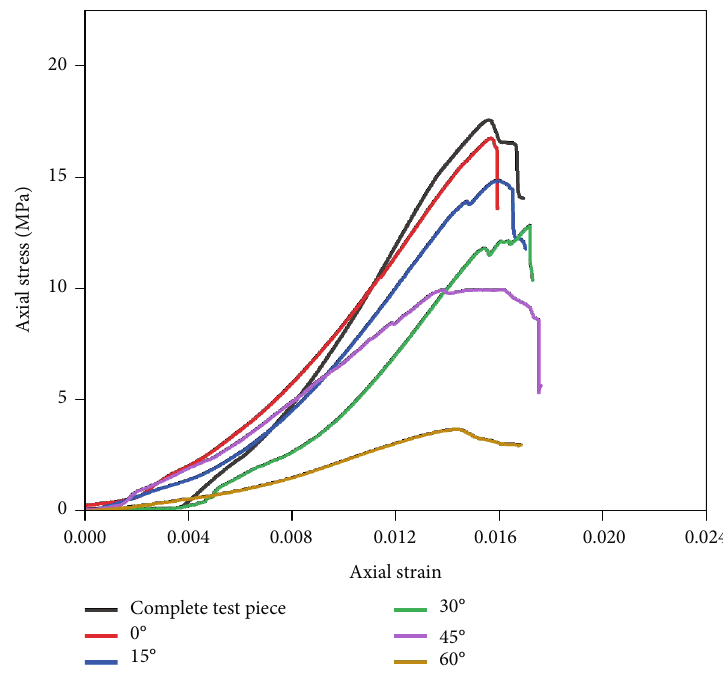
Figure 16: Uniaxial compressive stress-strain curves for specimens with di ff erent crack inclination angles.